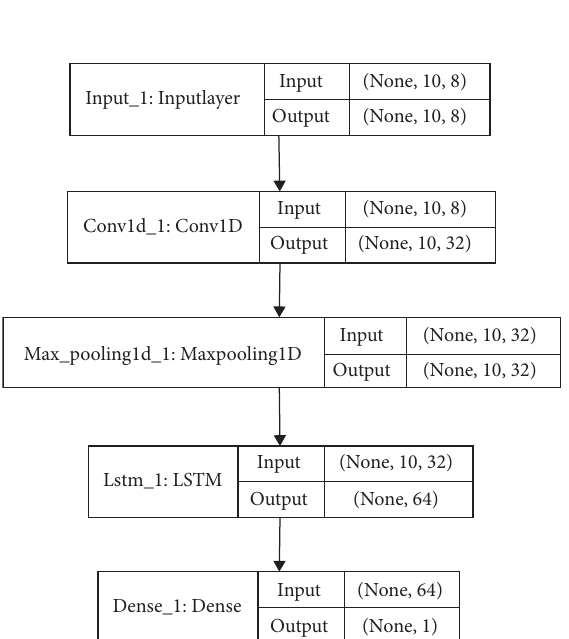
Figure 4: The model structure of